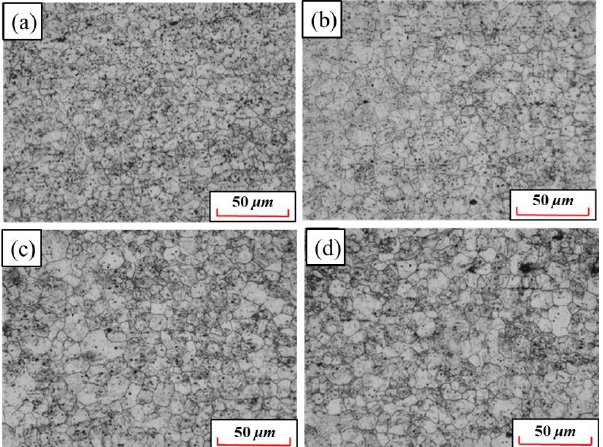
Figure 13. Grain distributions at different holding time: ( a ) 3 min; ( b ) 5 min; ( c ) 7 min; ( d ) 10 min.